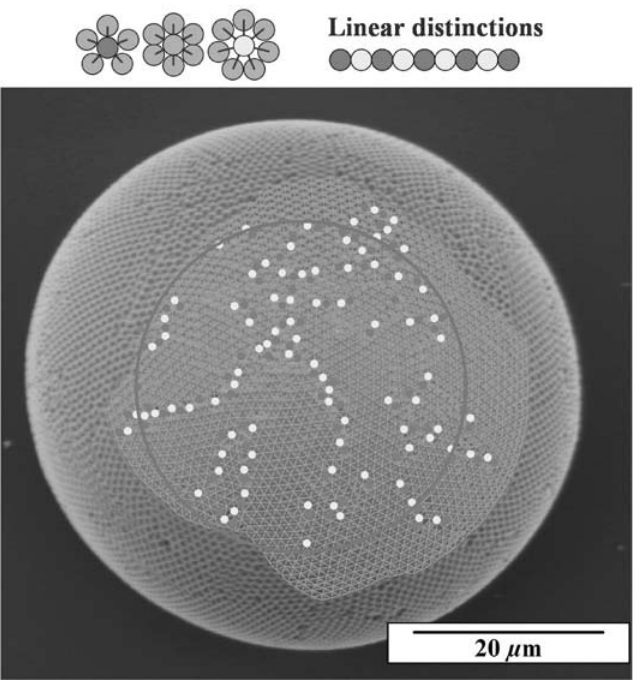
Fig. 5 Linear disclinations on a large spherical particle